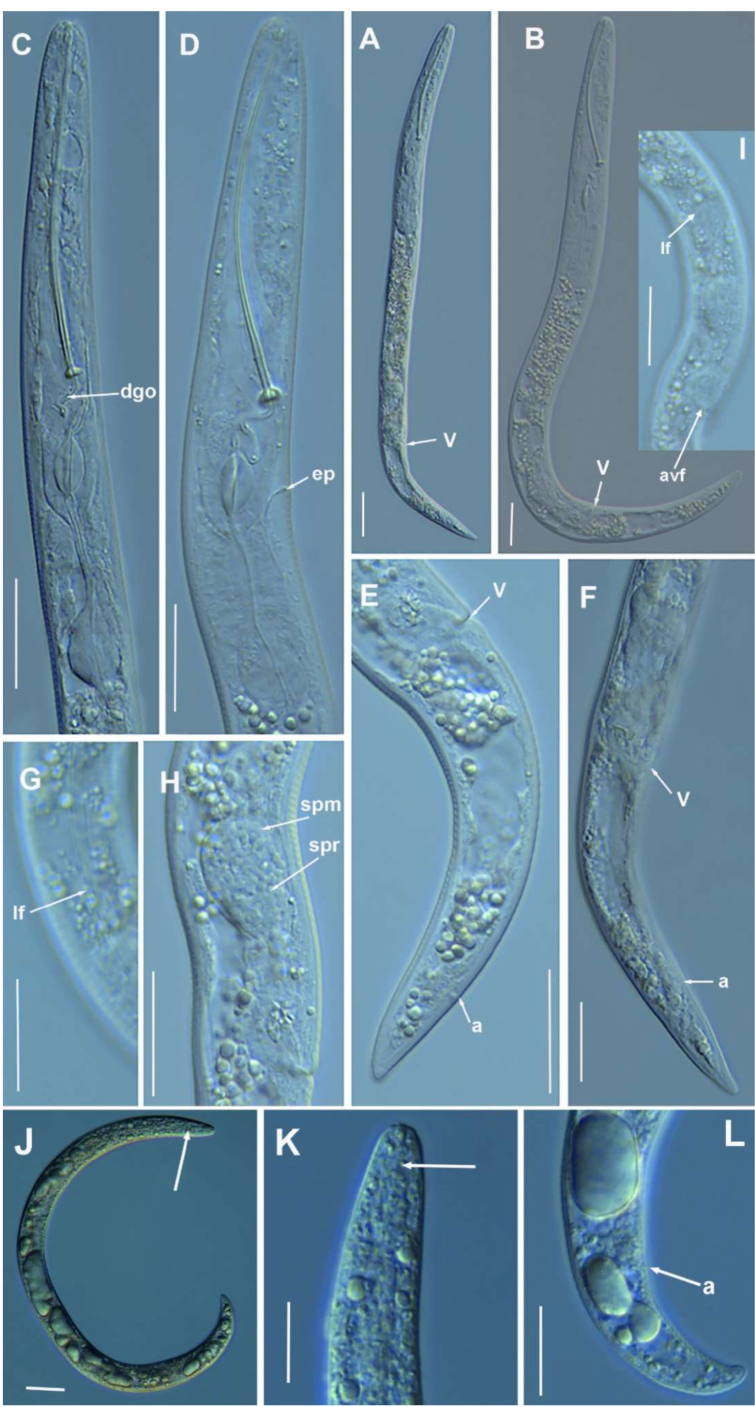
Figure 8. Light photomicrographs of Paratylenchus pandatus (Raski, 1976) Siddiqi, 1986. ( A , B ) entire females with vulva arrowed; ( C , D ) female pharyngeal region; ( E , F ) female posterior region showing vulva and anus (arrowed); ( G ) detail of lateral field (arrowed) at mid-body; ( H ) detail of spermatheca and sperm (arrowed); ( I ) detail of lateral field and advulval flap (arrowed); ( J ) entire fourth-stage juvenile, stylet absence arrowed; ( K ) fourth-stage juvenile lip region showing stylet absence (arrowed); ( L ) fourth-stage juvenile tail. Scale bars ( A – L = 20 µ m). (Abbreviations: a = anus; avf = advulval flap; dgo = pharyngeal dorsal gland orifice; ep = excretory pore; lf = laterl field; spm = spermatheca; spr = sperm; V =